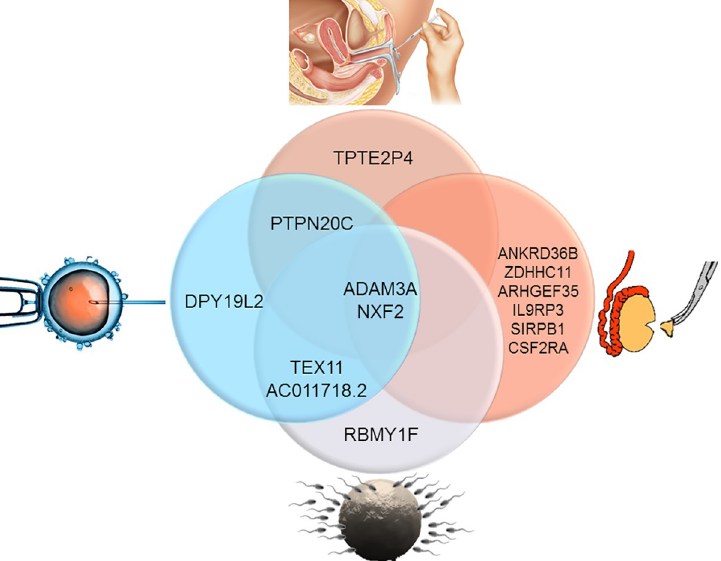
Fig 6. Gene mutation assessment according to ART treatment. Several gene mutation commonalities were identified when taking into consideration the type of assisted reproduction technique used. In couples treated by IUI, only a pseudogene ( TPTE2P4 ) was identifed while a gene involved in spermatogenesis ( RBMY1F ) were mutated in those treated by IVF. A gene supporting sperm acrosome formation ( DPY19L2 ) was mutated in men requiring ICSI. When we assessed gene mutations in men treated by testicular biopsy, a variety of genes were identified that play a role in basic cellular functions ( ANKRD36B ), androgen production modulation ( SIRPB1 ), or activation of germ cells ( CSF2RA ). Common gene mutations were also identified in patients who underwent multiple types of ART treatments. For instance, men treated by both IVF and ICSI shared an imbalance of TEX11 , a gene involved in meiotic crossing-over. All couples possessed gene mutations in ADAM3A and NXF2 , which support sperm-egg fusion and RNA nucleus-cytoplasmic transport,